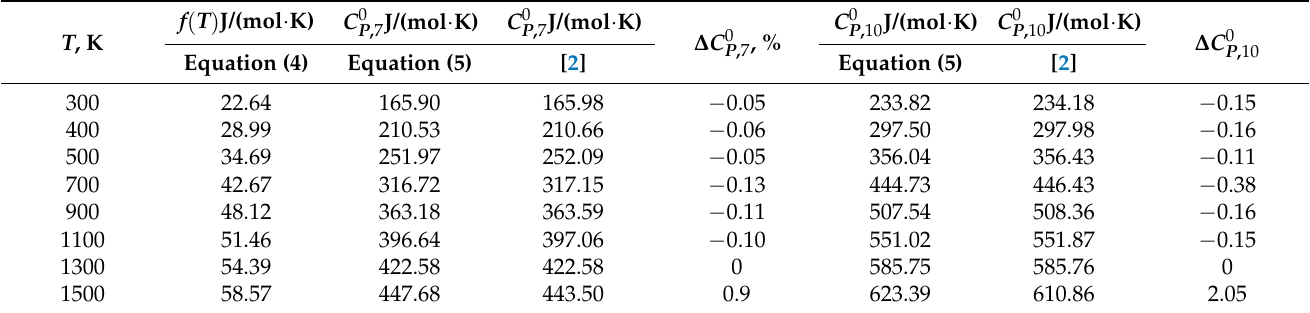
( T ) of n -C 7 H 16 and n -C 10 H 22 [2]. P